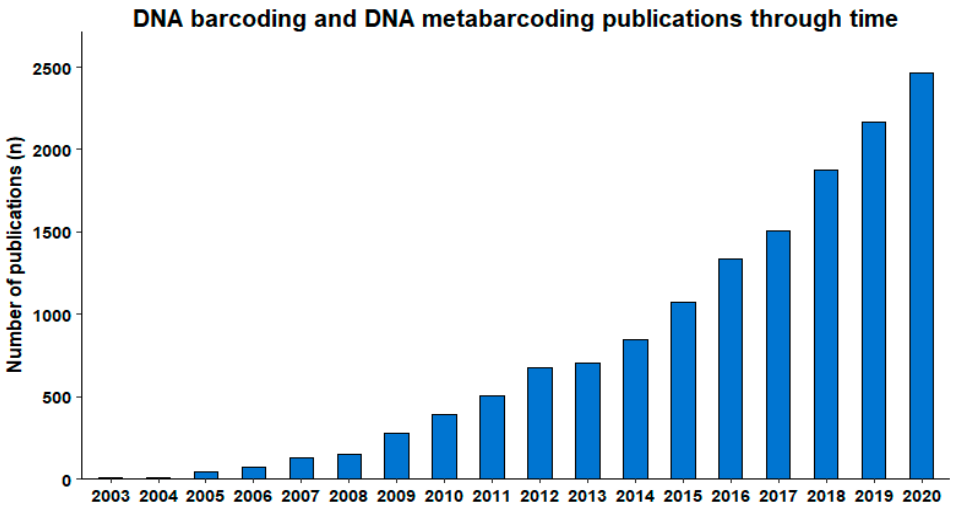
Figure 2. Publications per year registered in Scopus®, containing ‘DNA barcod*’ or ‘DNA metabarcod*’ in the title, abstract, or keywords (obtained 21 January, 2021).